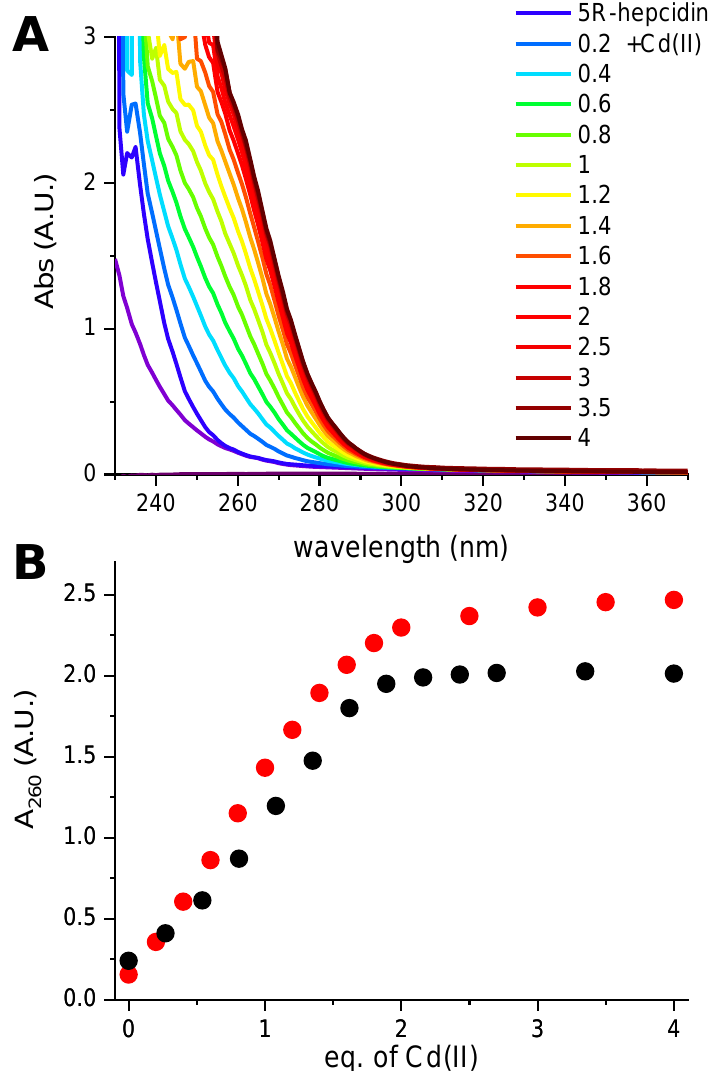
Figure 5. ( A ). 100 μM Zn 2 5R-hepcidin titrated with Cd(II) acetate in 100 mM HEPES pH 7.4. ( B ). The comparison of A 260 values for Cd(II) titrations of 100 μM 5R -hepcidin (black dots, data from Figure S2) and Zn 2 5R-hepcidin (red dots).